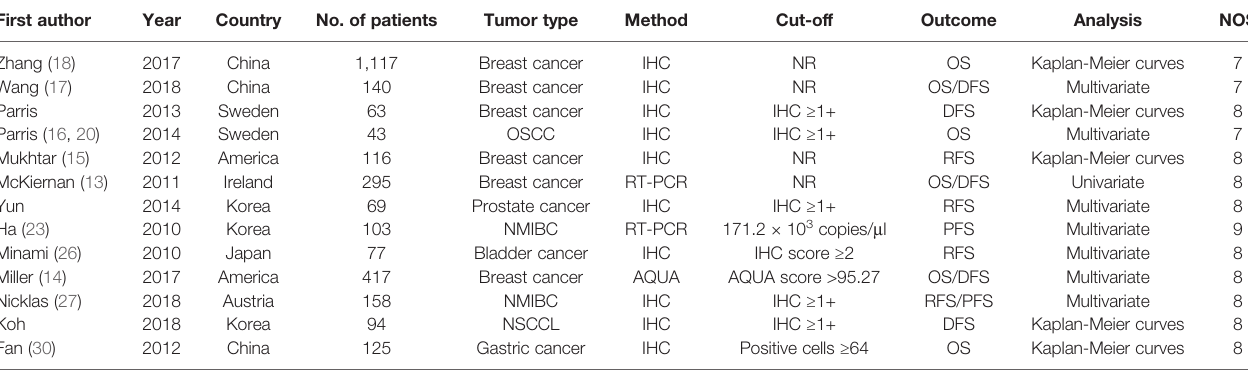
TABLE 1 | Summary of all included eligible studies.